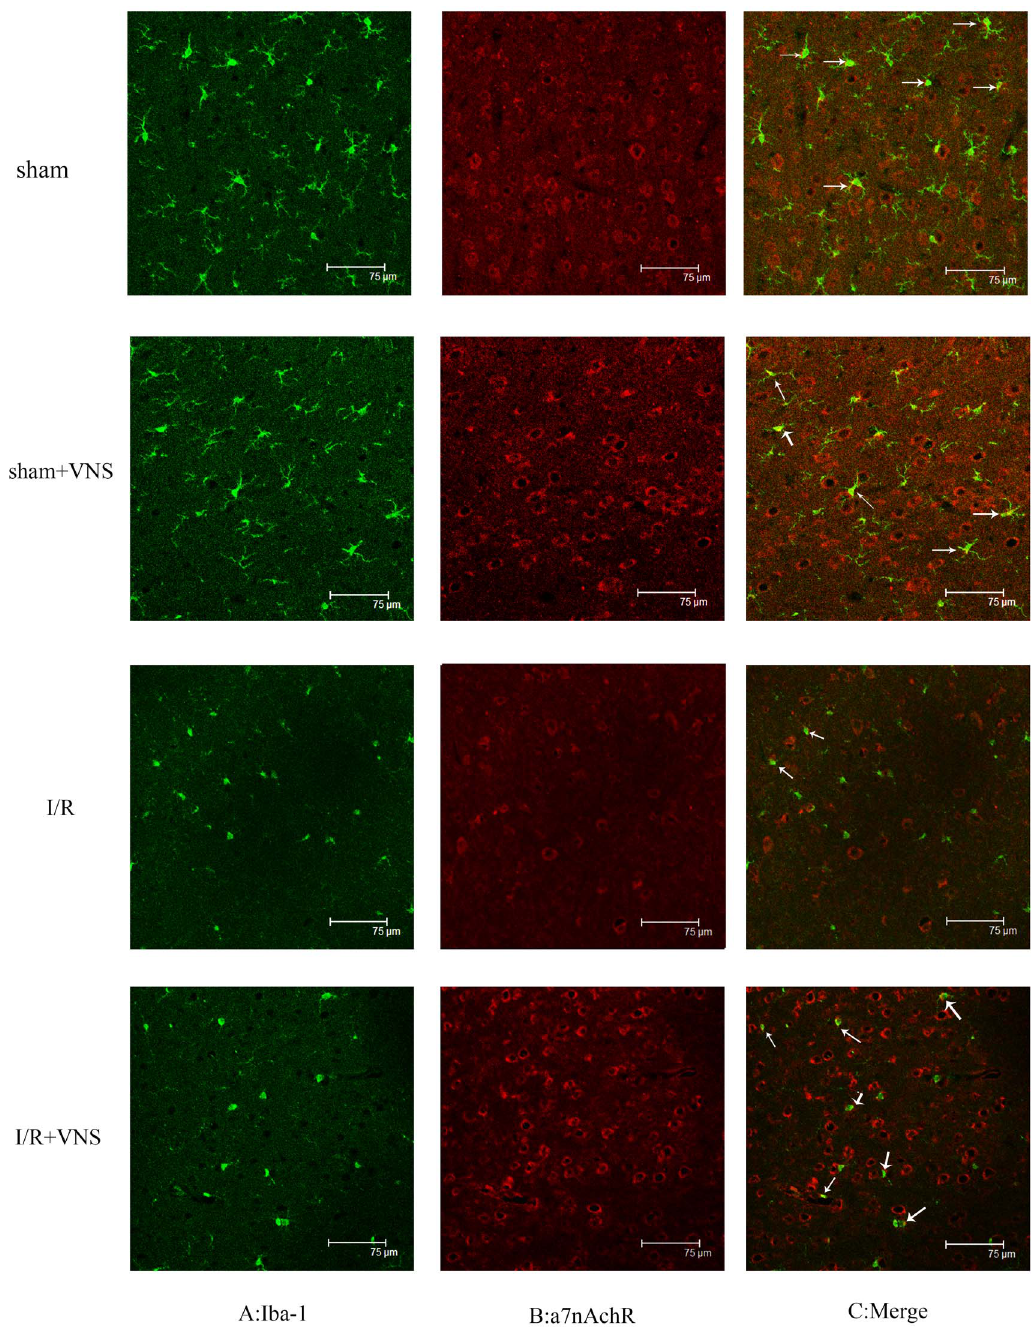
Figure 9. Immunostaining for a7nAchR on microglia (Iba-1) surface in ischemic penumbra. The expression of a7nAchR was reduced following I/R and increased by VNS. Underwent ischemic insults, the morphology of the microglial cell changed. A: Staining for a7nAchR in red, B: Staining (microglia) Iba-1 in green, C: merge of A and B. scare bar=75 m m.